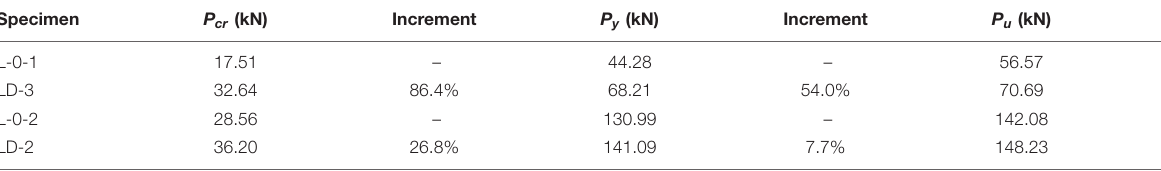
TABLE 4 | Cracking load, yield load, and ultimate load of specimens.